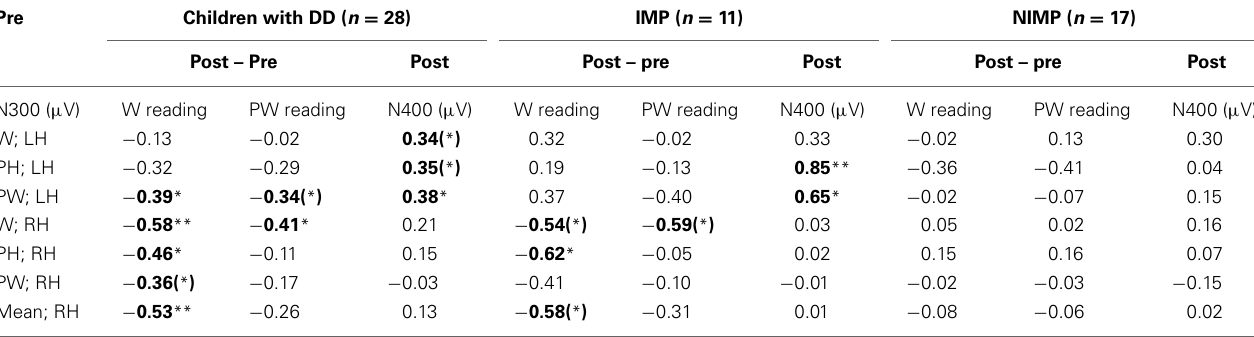
Table 7 | Pearson correlations across the whole group with DD and within the group of IMP and NIMP between the N300 before intervention and the gain in word and pseudoword reading fluency and the N400 after